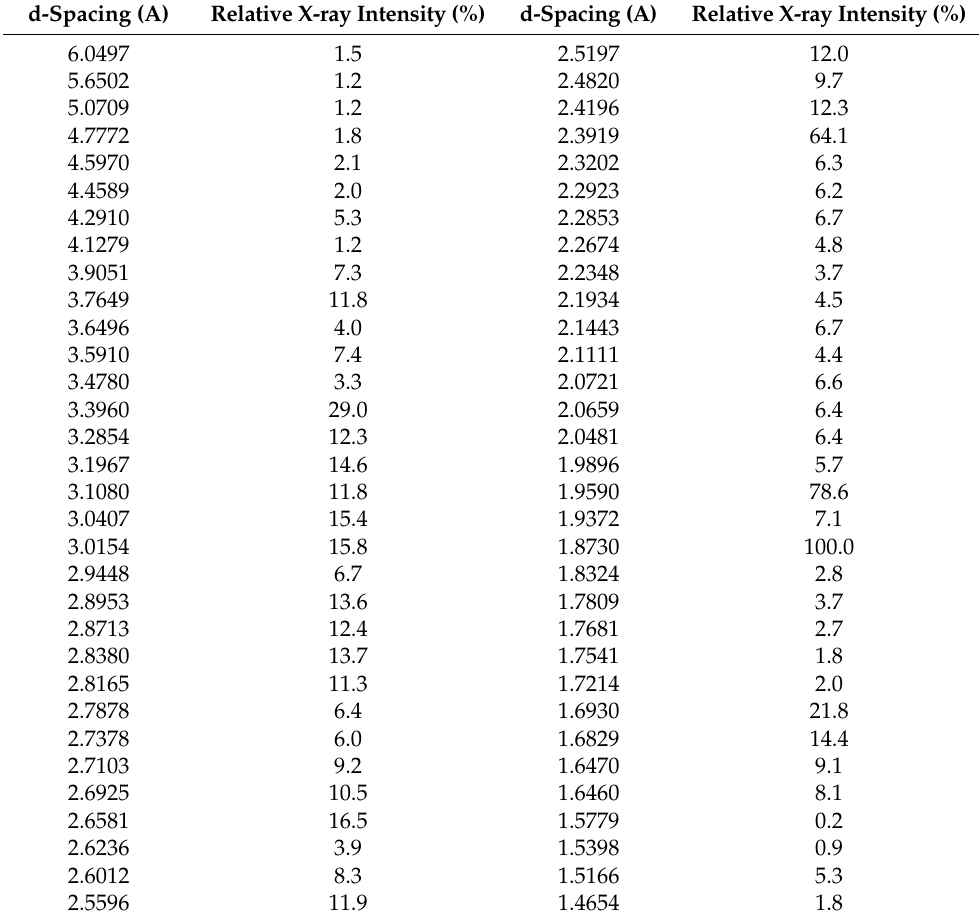
Table 1. Djurleite peak parameters obtained from the measured diffraction pattern